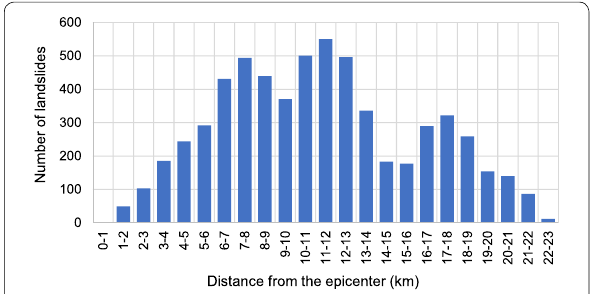
Fig. 4 Number of landslides and horizontal distances from the epicenter. Distances were measured by setting concentric circles with radii 1 km apart, originating at the epicenter